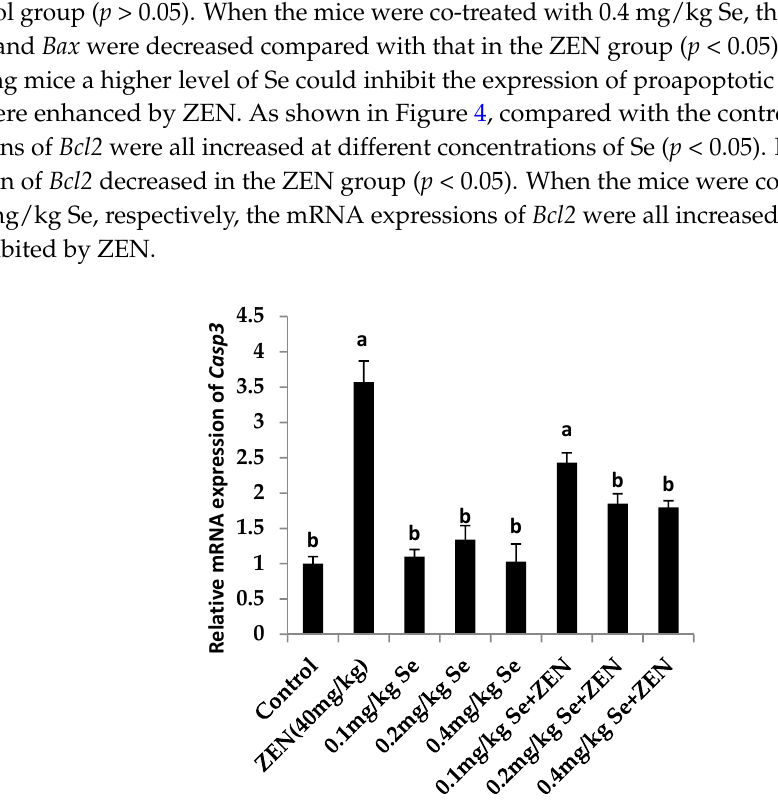
Figure 2. Effect of ZEN, different concentrations of Se and their co-treatment groups on the relative mRNA expression of Casp3 in mice testicular tissue. Values are mean ± SE of twenty mice in each group. a,b Means with different letters are significantly different, p < 0.05. a p < 0.05 vs. control group, b p < 0.05 vs. ZEN-treated group.